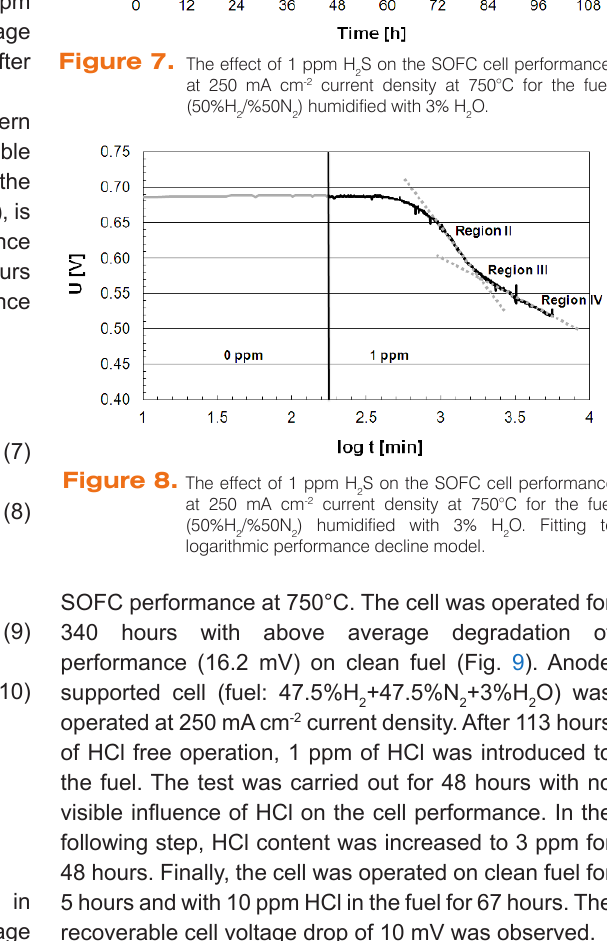
Figure 7. The effect of 1 ppm H